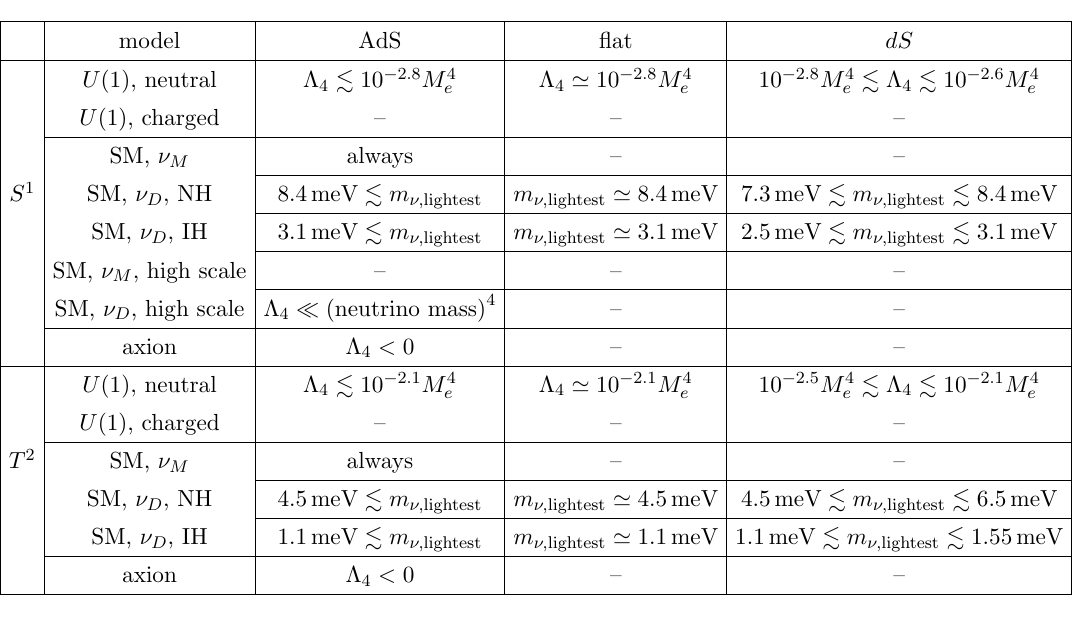
Figure 22 . The tree level stabilization of (cid:28)